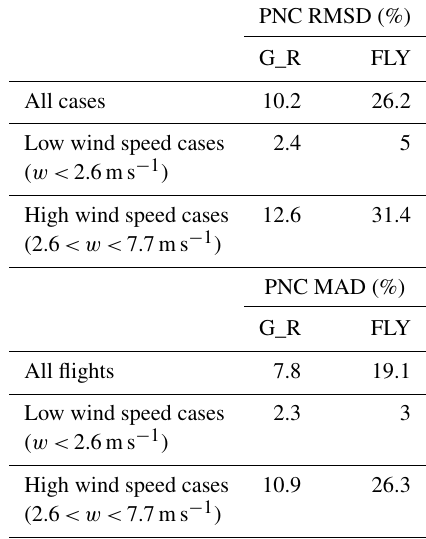
Table 3. Summary of RMSD and MAD for all cases, low wind cases, and high wind cases.